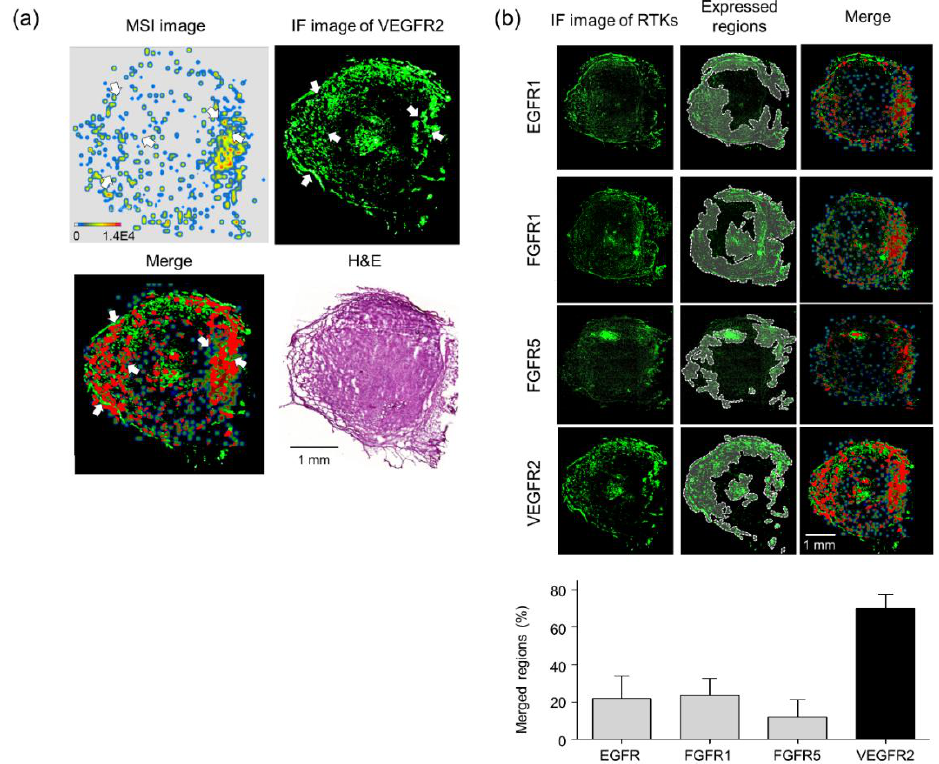
Figure 6. Validation of target interaction by colocalization of voacangine with VEGFR2 and other RTKs. ( a ) Comparison of voacangine MSI (precursor ion) and immunofluorescence staining of the target candidate, VEGFR2, in voacangine-treated tumor tissue. The overlaid image with transparent MSI signal on the immunofluorescence staining image for VEGFR2 is visualized in the merged region (red). Scale bar, 1 mm. ( b ) Comparisons and quantitation of merged regions for voacangine distribution and RTK receptors (EGFR1, FGFR1, FGFR5, and VEGFR2) in tumor tissues. Regions of expression for each RTK are indicated with white dashed lines on the immunofluorescence images. The merged regions are visualized in red. The results shown are representative of three independent experiments. Each value represents the mean ± S.D. from three independent experiments. Scale bar, 1 mm. Table 2. Comparison with other RTKs in voacangine-treated tissues. Each value represents the mean from three independent experiments. IF: immunofluorescence-stained regions. Voa, voacangine.